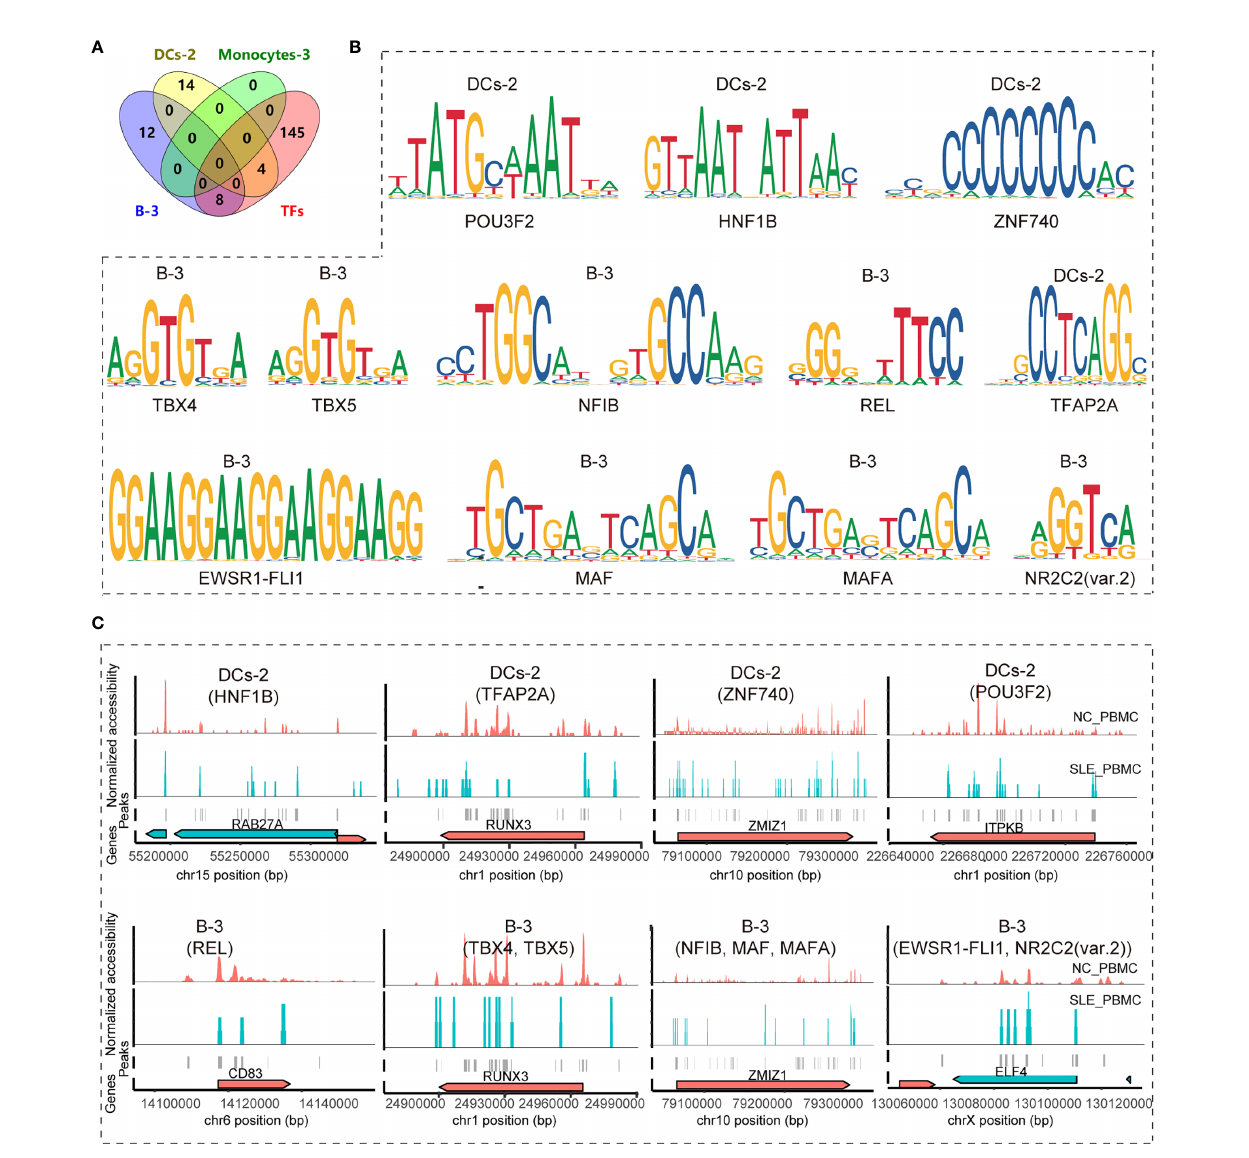
FIGURE 4 | Identifying key TF regulators and their regulatory networks involved in the T cell activation pathway. (A) Venn diagram showing the distribution of enriched TF regulators in B-3, Monocyte-3, and DC-2 between the SLE_PBMC and NC_PBMC libraries (p <0.05, FC >2) and the 157 TF regulators involved in regulating the target genes (BCL11B, CCR7, CD83, ELF4, ITPKB, NCK2, NKAP, RAB27A, RUNX3, and ZMIZ1) to activate T cells; (B) Position weight matrices (PWMs) for the shared TFs in (A) ; (C) Example locus near RAB27A, RUNX3, ZMIZ1, ITPKB, CD83 and ELF4 with differential accessibility between the SLE_PBMC and NC_PBMC libraries across DC-2 and B-3. SLE_PBMC, PBMCs from patients with systemic lupus erythematosus (SLE); NC_PBMC, PBMCs from healthy controls; NK cells, natural killer cells; DCs, dendritic cells. The p-values in this manuscript were calculated with Loupe Cell Browser 3.1.1 through the difference analysis feature and adjusted using the Benjamini – Hochberg correction for multiple